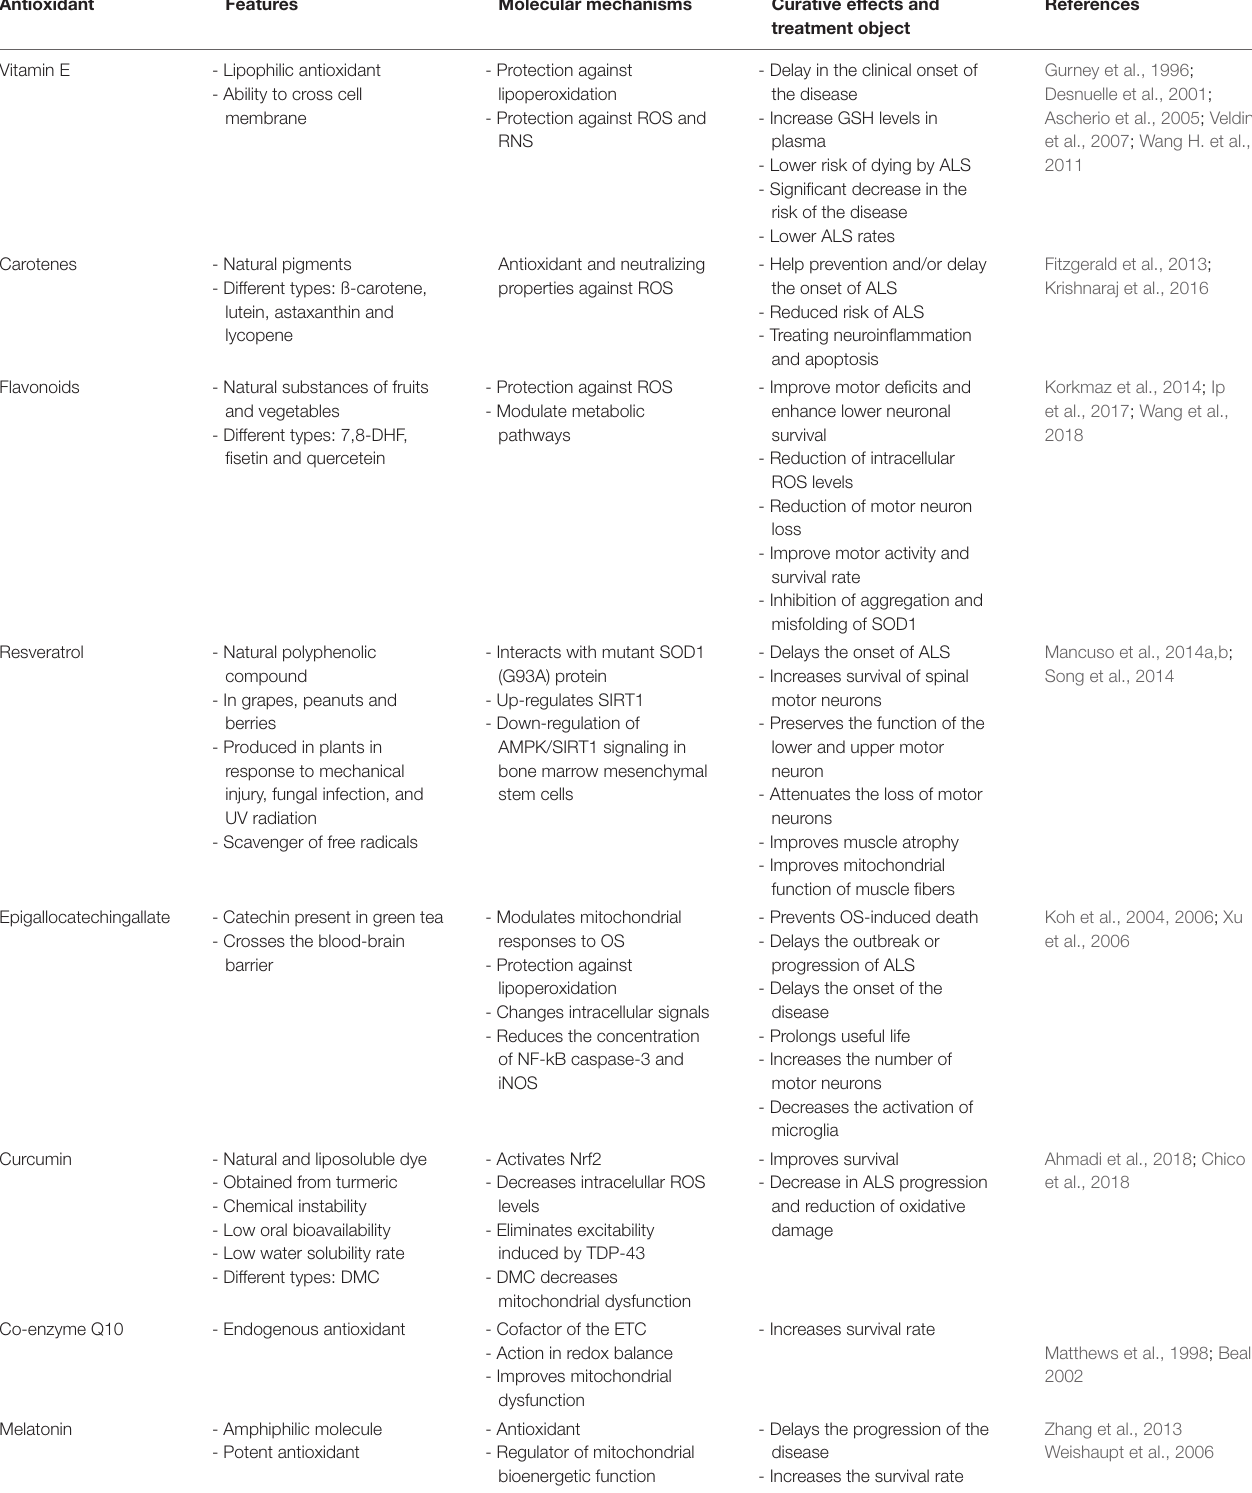
TABLE 1 | Antioxidant compounds used in the treatment of